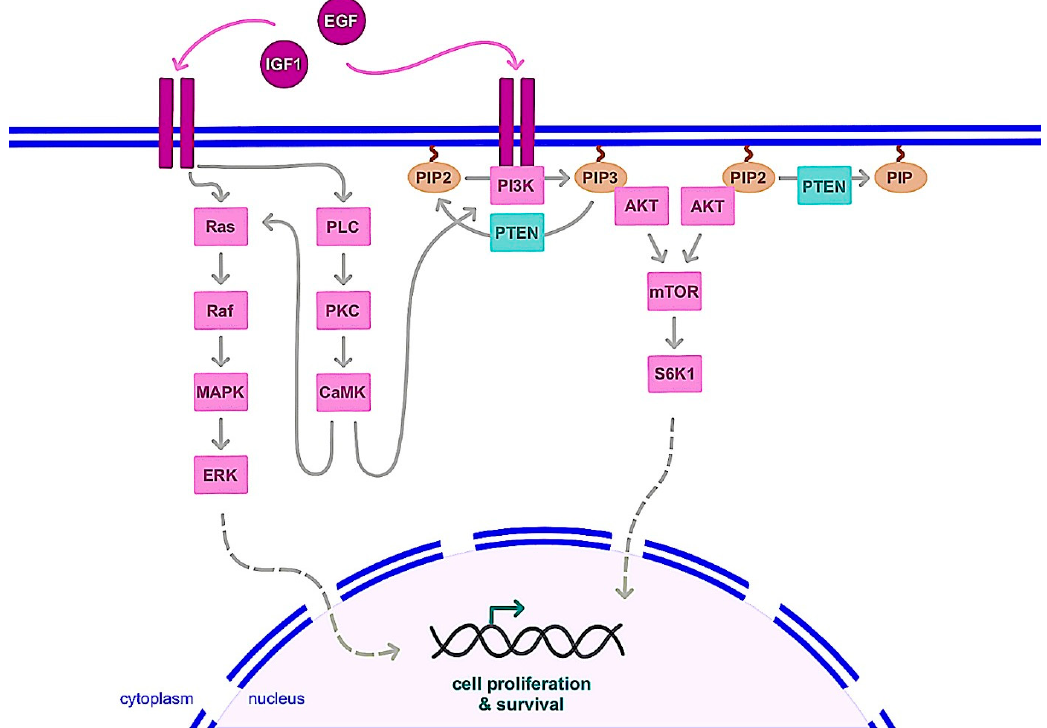
Figure 2. Main signaling pathways leading to cell proliferation and survival following growth factor receptors stimulation. Growth factor receptors stimulation by EGF or IGF1 for example activates signaling pathways involving notably Ras/MAPK/ERK or PI3K/AKT/mTOR, leading to transcription factors activation for the regulation of cell fate. The activation of AKT by PI3K involves PIP2 phosphorylation, which is inhibited by PTEN. CaMK: Ca 2+ /calmodulin-dependent protein kinase; EGF: epidermal growth factor; IGF1: insulin like growth factor 1; MAPK: mitogen-activated protein kinase; mTOR: mammalian target of rapamycin; PI3K: phosphoinositide 3-kinase; PIP: phosphatidylinositol phosphate; PKC: protein kinase C; PLC: phospholipase C; PTEN: phosphatase and tensin homolog; S6K1: S6 kinase